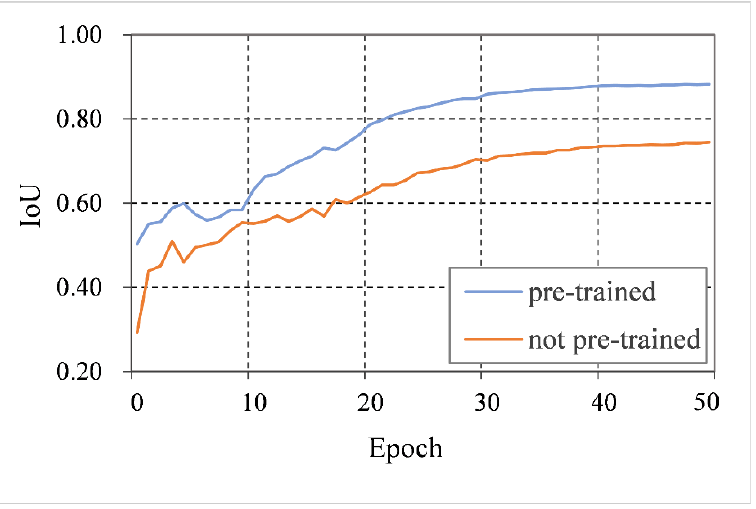
Figure 9. IoU of the pre-trained and not pre-trained D-ResUnet model.